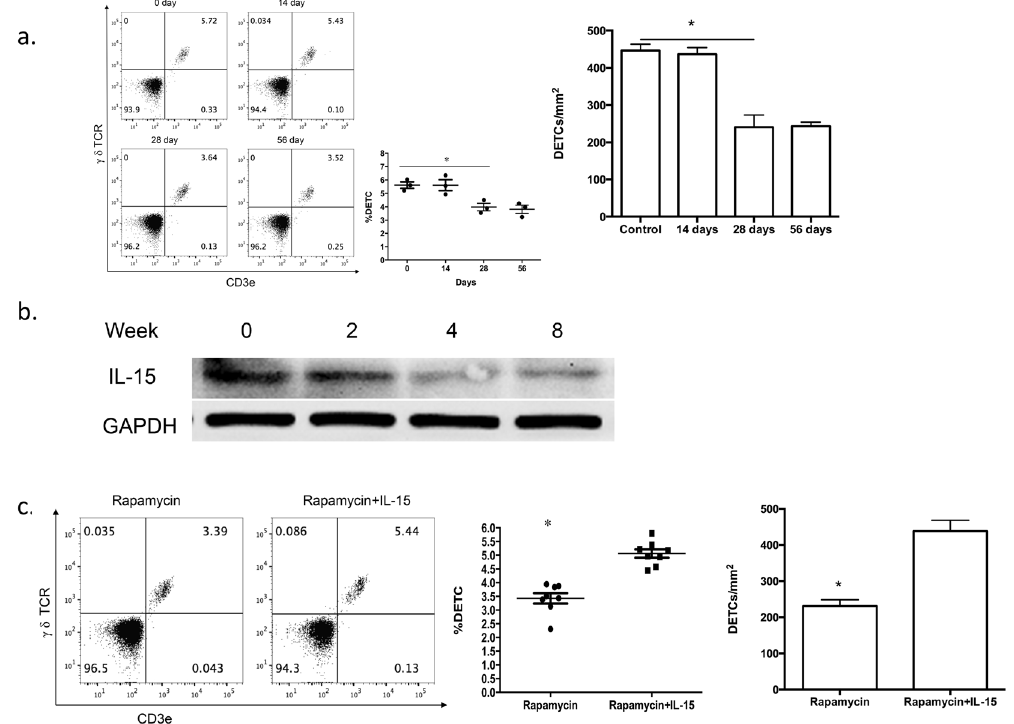
Figure 3. Addition of IL-15 recovers rapamycin-mediated abnormal DETC homeostasis. ( a,b ) 6–8 weeks wild- type male C57BL/6J mice were administered rapamycin or vehicle control daily for 8 weeks. At 8 weeks after administration of the vehicle control and at, 2, 4, and 8 weeks after rapamycin treatment, epidermal sheets were obtained for assessing the number of DETCs by FACS (panel a) and the production of IL-15 by Western analysis (panel b). ( c ) IL-15 (1 μ g) or vehicle control was intradermally injected daily on the back skin of rapamycin- treated mice for 3 days, and epidermal sheets were excised for assessing the number of DETCs by FACS. All data represent at least three independent experiments and each experiment includes 6 animals (3 control and 3 experimental mice). All error bars represent mean ± SEM. * P <